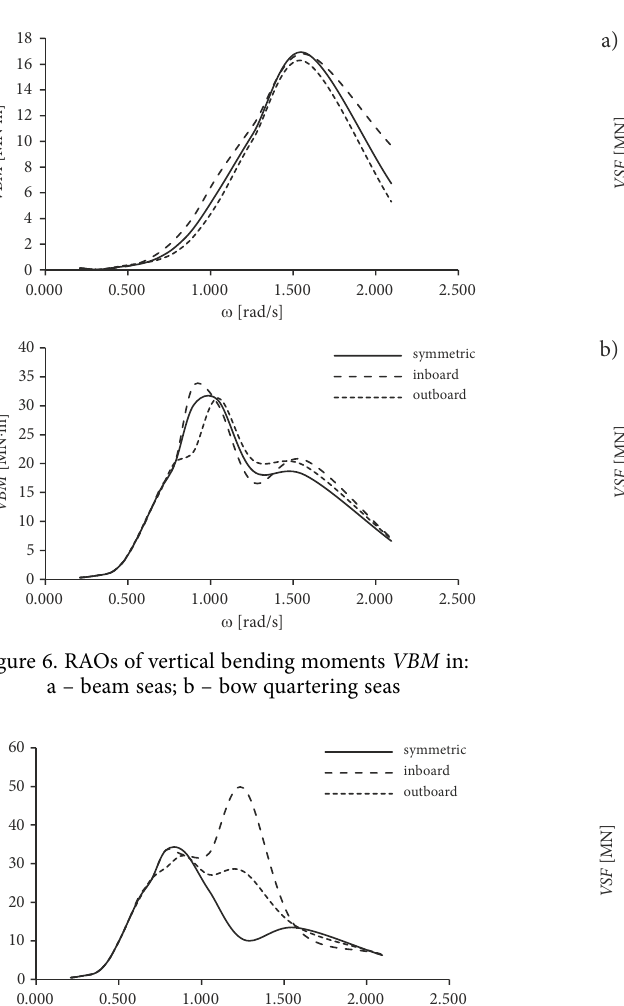
Figure 9. RAOs of vertical shear forces VSF in head